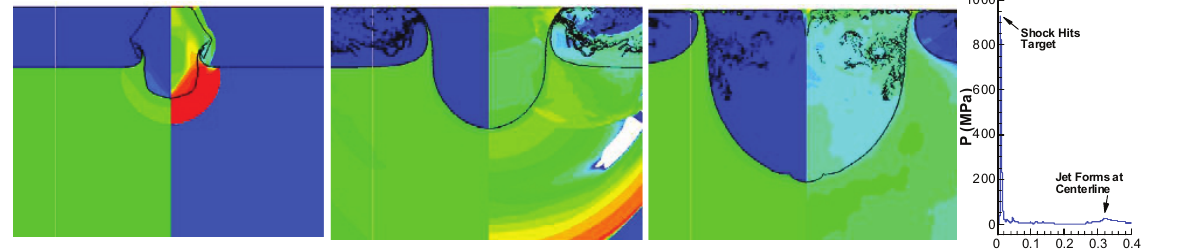
Fig. 17. Flow field for a surface plate and depth of 2 cm.